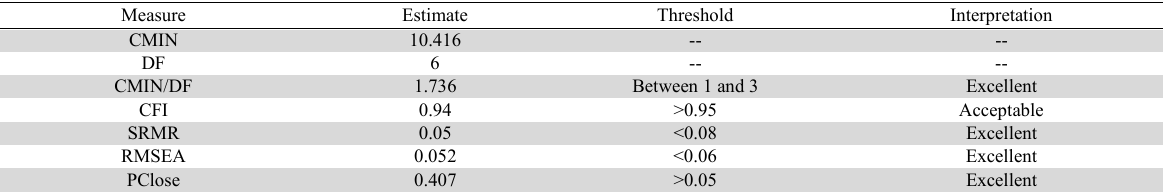
Model fit indices for the structural model